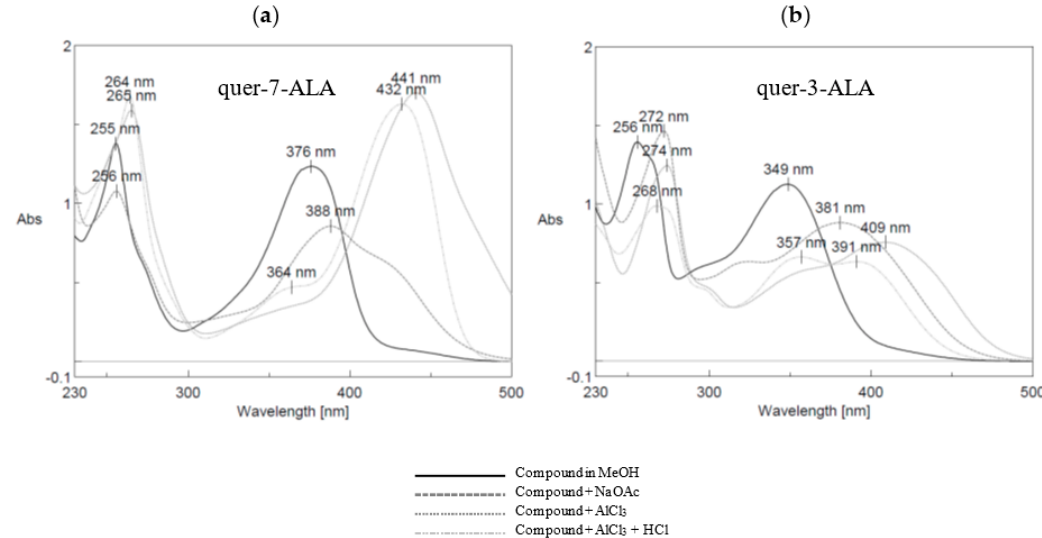
Figure 6. UV spectra of quer-7-ALA ( a ) and quer-3-ALA ( b ) under different conditions: in MeOH, with NaOAc, with AlCl 3 and with AlCl 3 + HCl.